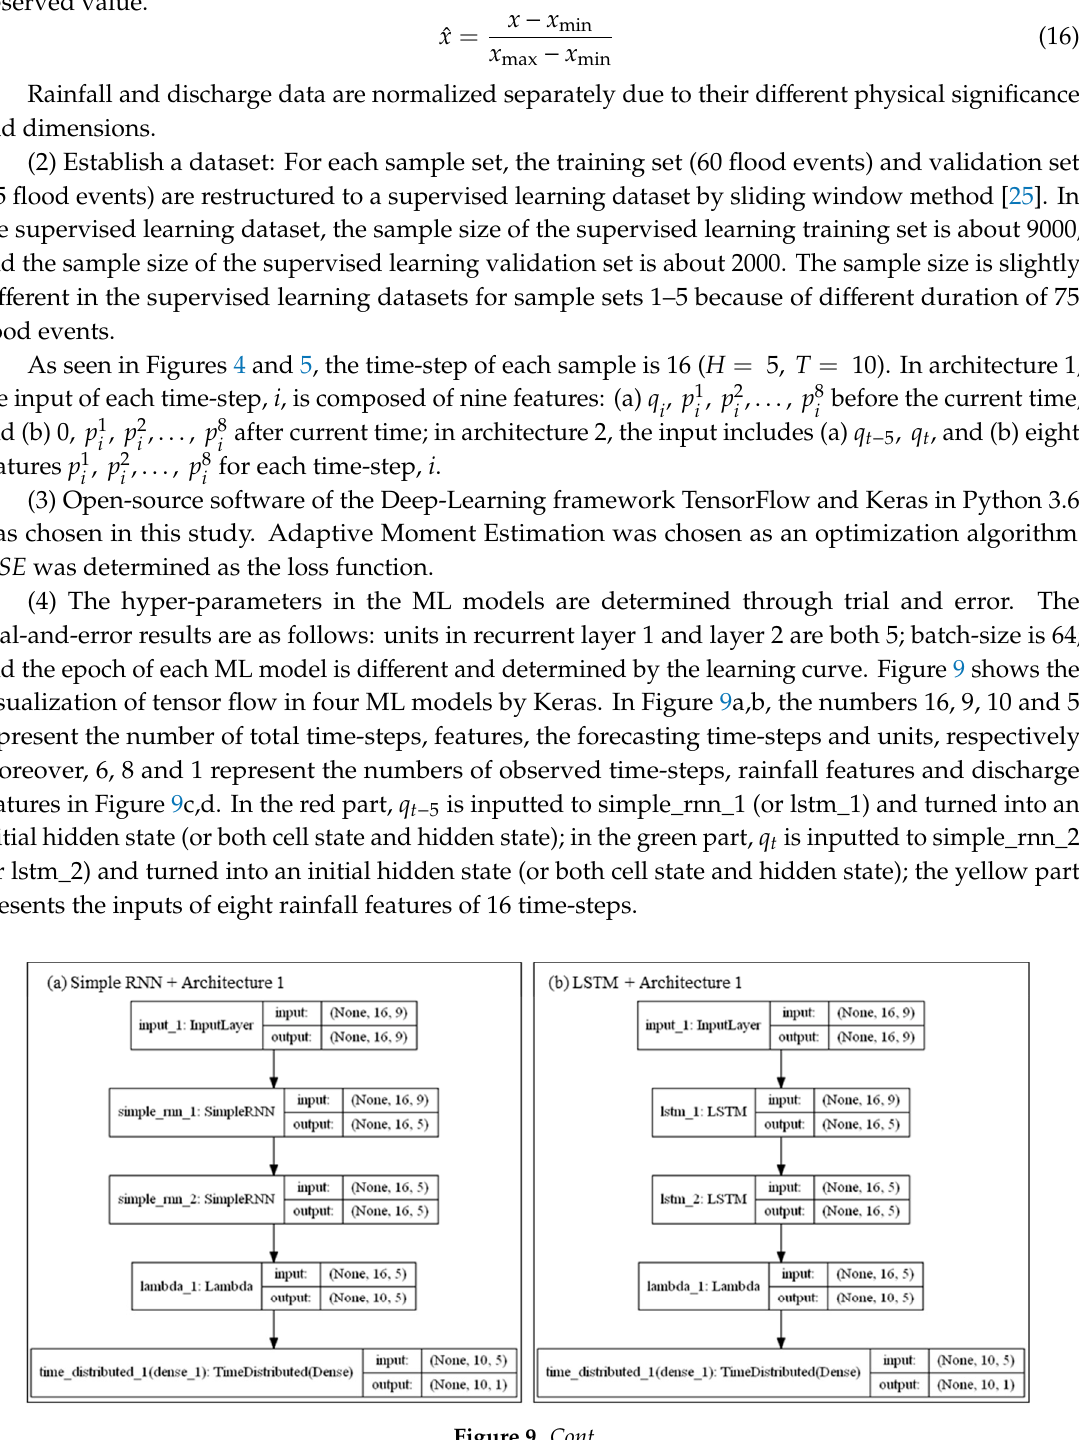
Figure 9. Visualization of tensor flow in ML models.